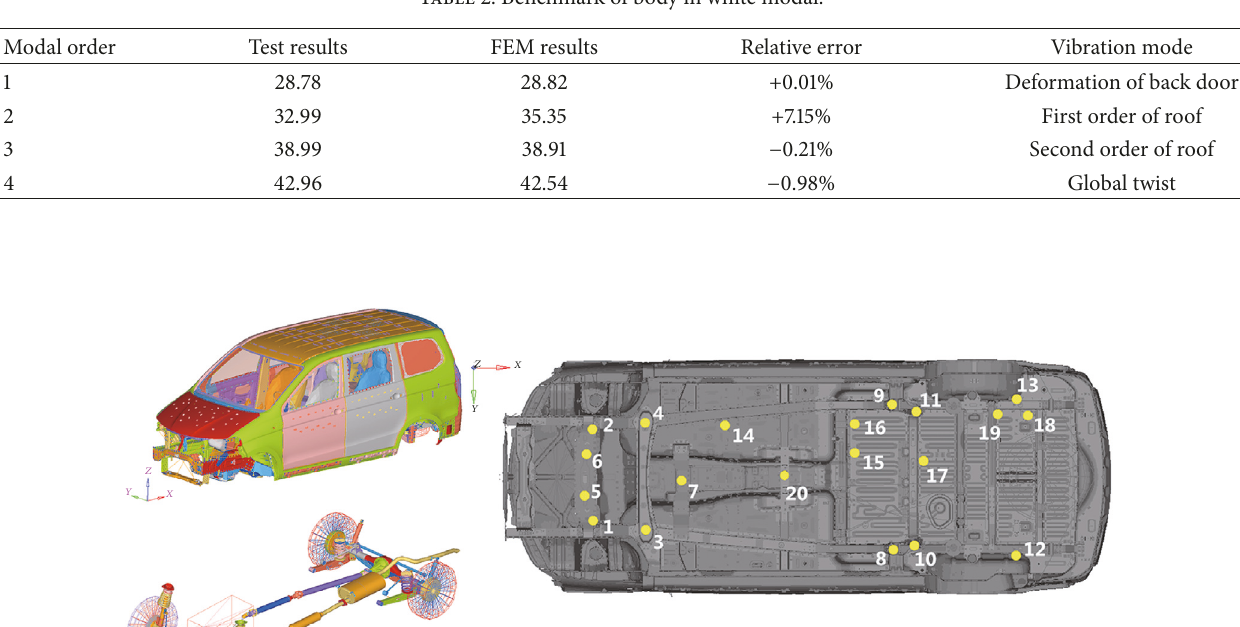
Table 2: Benchmark of body in white modal.